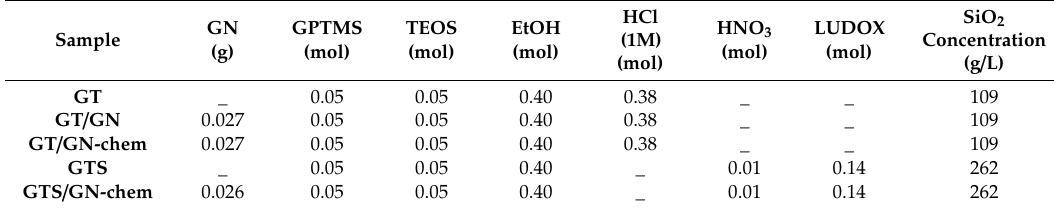
Table 1. Compositions and mole ratios of the precursors used to prepare di ff erent hybrid silica sols with and without graphene